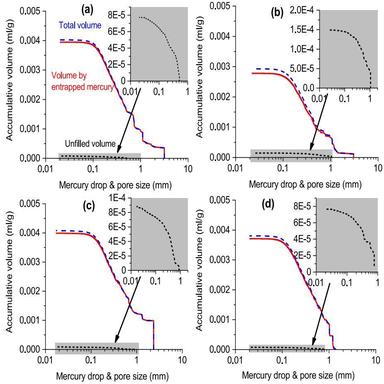
Size distributions of entrapped mercury drops and unfilled pores (sub panels) for (a) P03-15, (b) P03-30, (c) P03-60 and (d) P03-30SC samples.